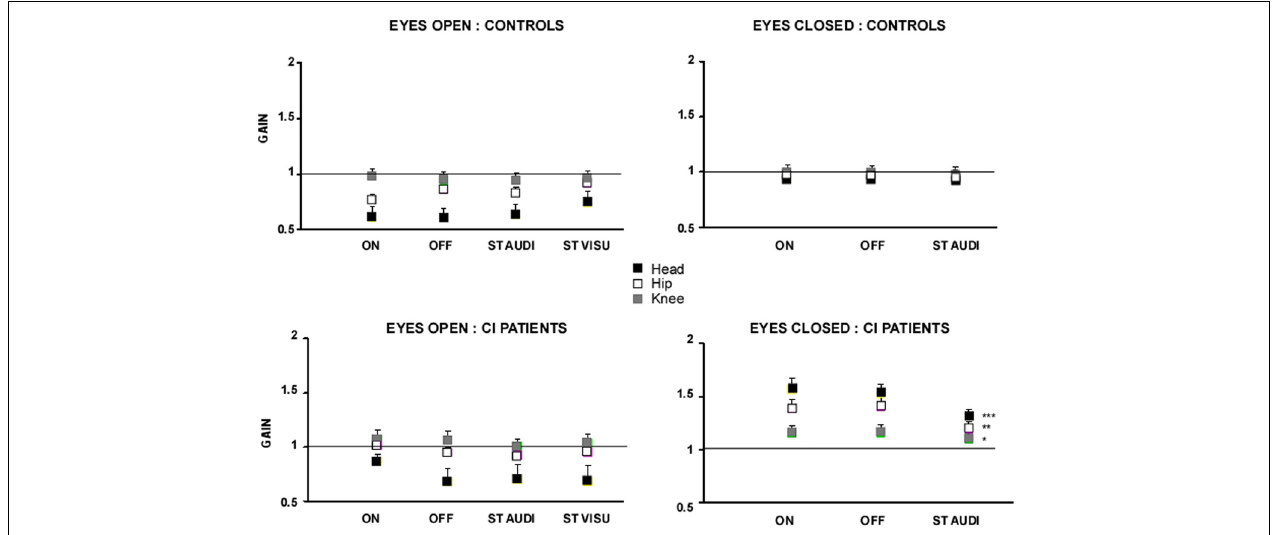
FIGURE 3 | Gain of the head, hip and knee body segments during sinusoidal platform translation at the 0.5Hz frequency. The gains of the head (filled black squares), hip (open squares), and knee (filled gray squares) body segments, evaluated from motion analysis (Codamotion), were calculated as the ratio between platform displacement and displacement of the different body segments. Gains close to unity mean that the body segments move in phase and with the same amplitude as the platform; lower and higher gains for the